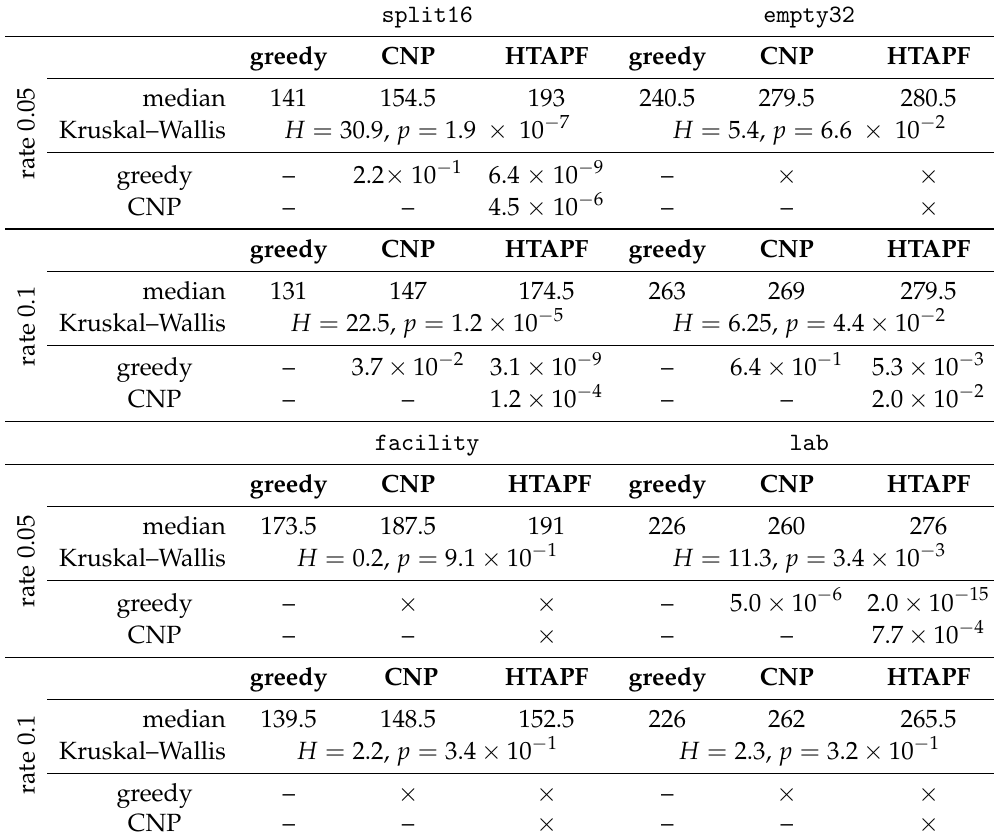
Table 3. Results of the statistical tests on the simulations performed with different rates of robot